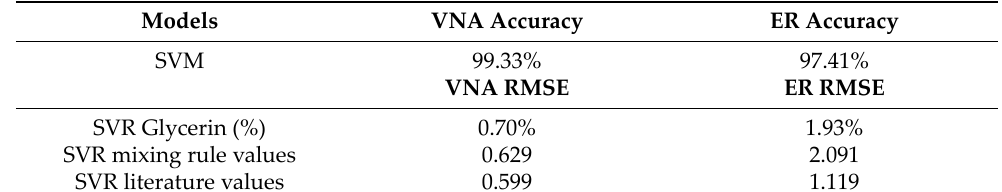
Table 3. ML performance results.